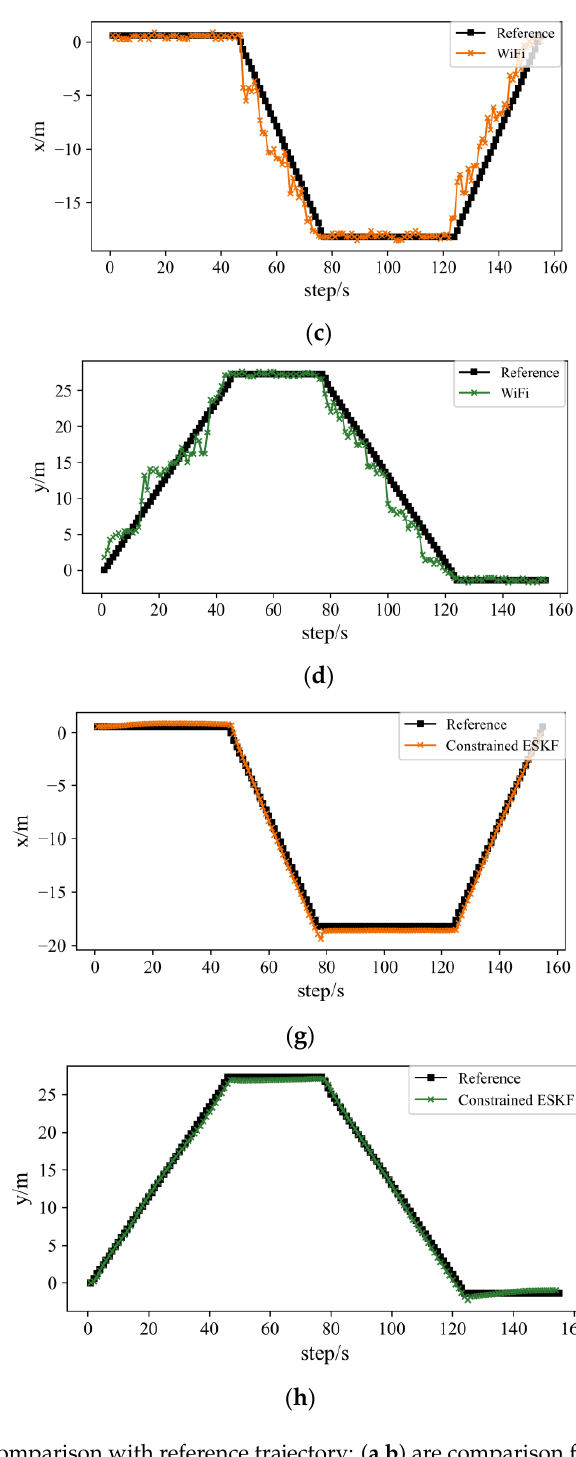
Figure 9. Figures of ESKF-based and constrained ESKF experiment results and comparison figures: ( a ) Figure of IMU-based and ESKF positioning trajectory comparison; ( b ) Figure of WiFi-based and ESKF positioning trajectory comparison; ( c ) Figure of ESKF and constrained ESKF positioning tra- jectory comparison; ( d ) Error figure of three positioning methods; ( e ) Error figure of data fusion method and optimization positioning method.